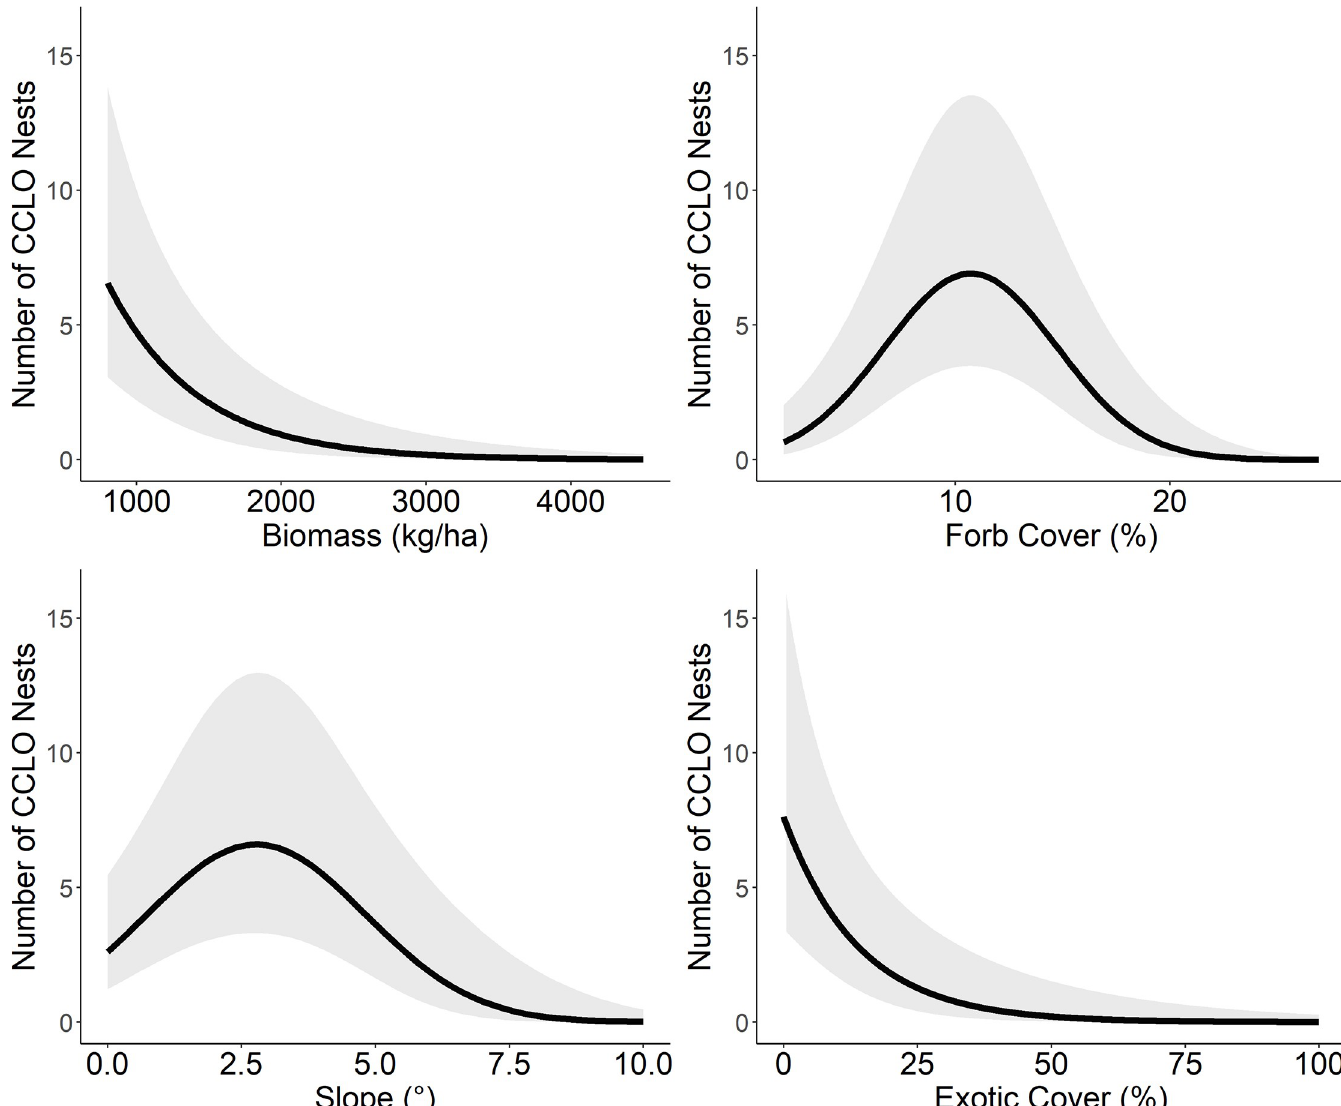
Fig 1. Predicted effect of relevant habitat features on chestnut-collared longspur nest density. Predicted effects of plot-scale herbaceous biomass, forb cover, slope, and exotic grass cover on the number of chestnut-collared longspur nests in Phillips County, Montana during May–June 2017–2018. Shaded areas represent 95% confidence intervals adjusted for